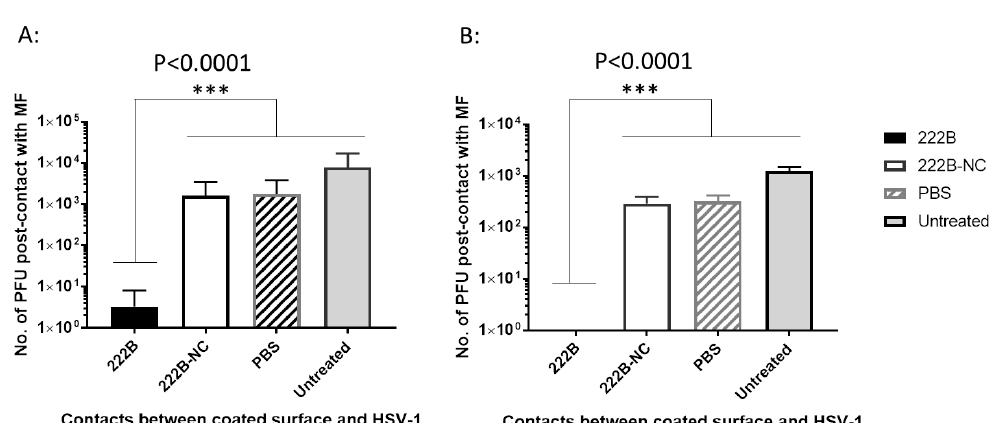
Figure 9. Contact inhibition against HSV-1 on the 222B coated fabric surface within 3–5 min. The mask fabric surface was exposed to input viruses at ~1.45 × 10 4 PFU ( A ) or ~1.45 × 10 3 PFU ( B ) per cm 2 . The X-axis stands for contacts between coated surfaces and HSV-1; the Y-axis represents the number of PFU post-contact with the coated fabrics. The solid bar stands for direct contact between 222B and HSV-1 (222B); the open bar stands for the no direct contact between HSV-1 and 222B (222B-NC); striped bar stands for direct contact between PBS coated surface and HSV-1 (PBS), and the gray bar stands for HSV-1 diluted in PBS directly (Untreated). The viruses eluted after direct contact were quantified by standard plaque assay as average PFU post 222B contact ( n = 3). A significant statistical difference from the 222B-NC and PBS control is marked with *** p < 0.0001 (two-way ANOVA with Bonferroni post-test).